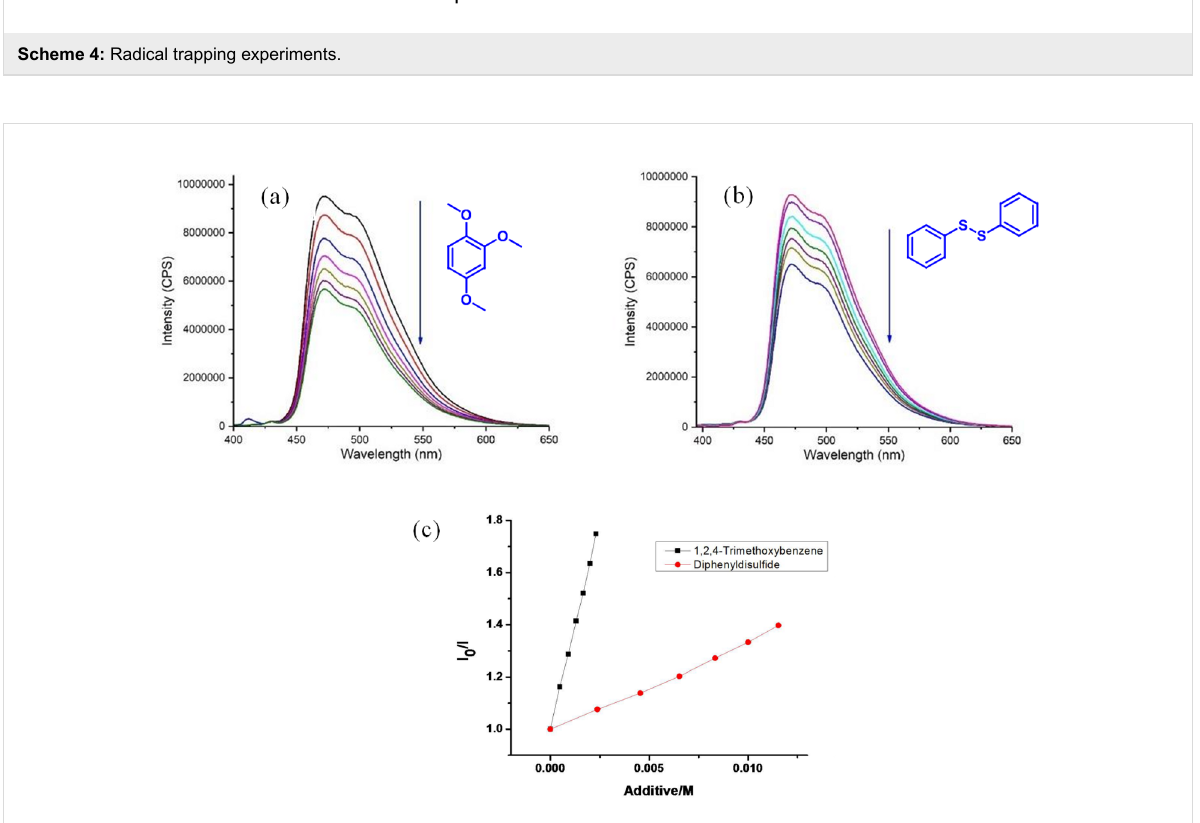
Figure 3: (a) Changes in the fluorescence spectra (in this case intensity, λ Ex = 455 nm) of [Ir(dF(CF 3 )ppy) 2 (dtbpy)]PF 6 upon the addition of 1,2,4- trimethoxybenzene in CH 3 CN. (b) Changes in the fluorescence spectra upon the addition of diphenyl disulfide in CH 3 CN. (c) Stern–Volmer quenching plot of iridium catalyst in the presence of 1,2,4-trimethoxybenzene and diphenyl disulfide. K q (arene) = 318 ± 2.6 M − 1 L and K q (disulfide) = 36 ± 0.7 M − 1